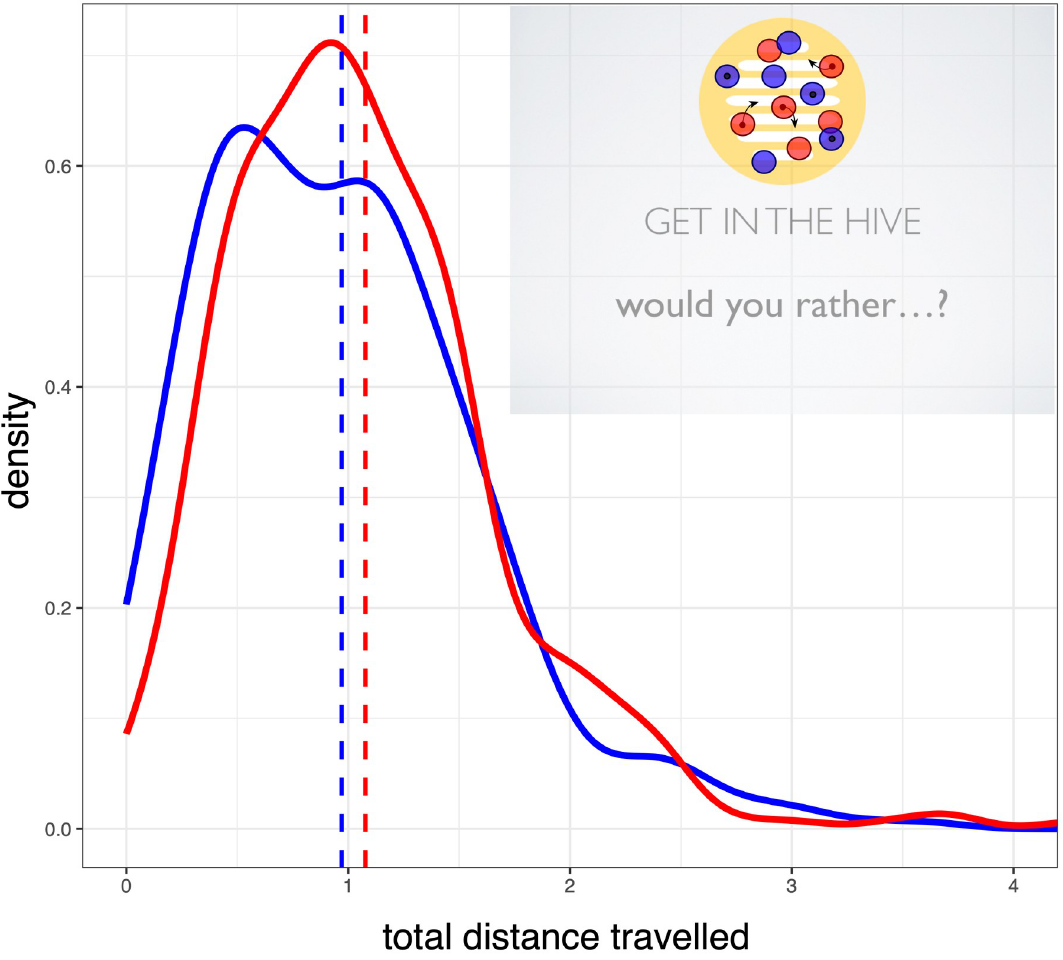
Fig 4. Distribution of the total distance participants travelled while waiting inside the yellow circle, split by dot colour. Inset shows an example trial, with confederate dots marked with a spot.